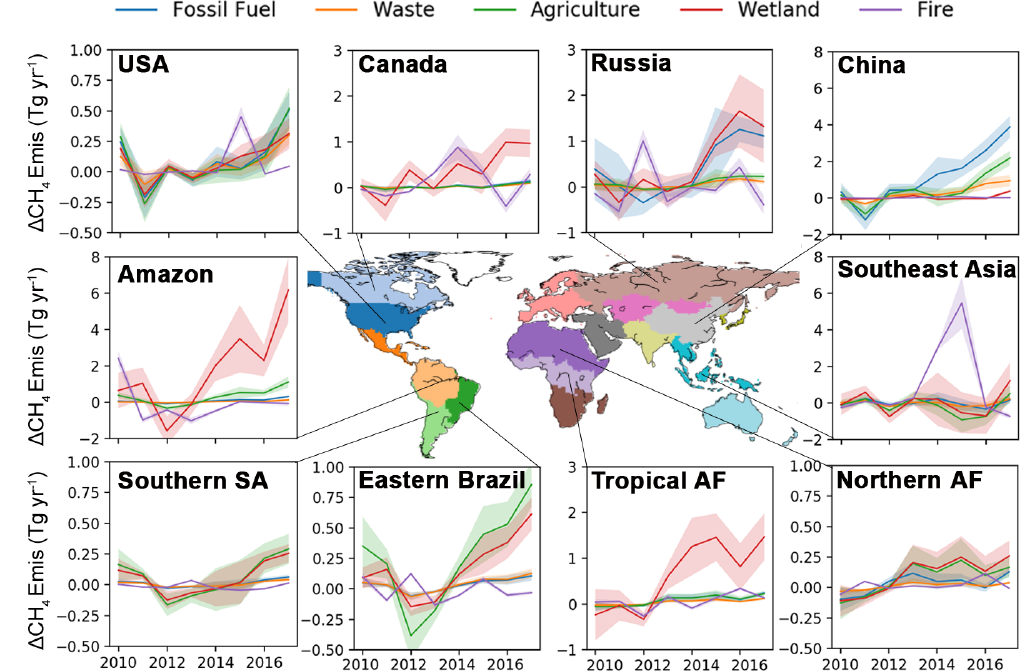
Figure 8. Regional emission anomalies relative to the 2010–2013 mean for the sectoral attribution based on prior information. Note the scales on the y axis are different for each